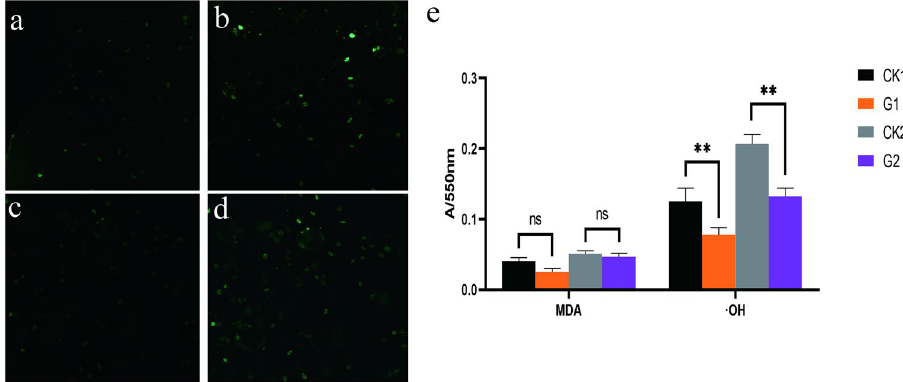
Figure 2. Effect of G. lucidum aqueous extract on ROS, MDA and ·OH in T. thermophila . ( a – d , ×100). ( a ) ROS fluorescence in the logarithmic phase of the control group. ( b ) ROS fluorescence showed in the control group during the decline phase. ( c ) ROS fluorescence in the logarithmic phase of the experimental group applicated with G. lucidum aqueous extract. ( d ) ROS fluorescence in the decline phase of the experimental group applicated with G. lucidum aqueous extract. ( e ) The accumulation of MDA volume and ·OH in logarithmic and decline phases in the control and experimental groups. Symbols: CK1, the logarithmic phase of the control group. CK2, the decline phases of the control group. G1, the logarithmic phase of the experience group. G2, the decline phase of the experience group. * p < 0.05, ** p < 0.001, ns, not significant